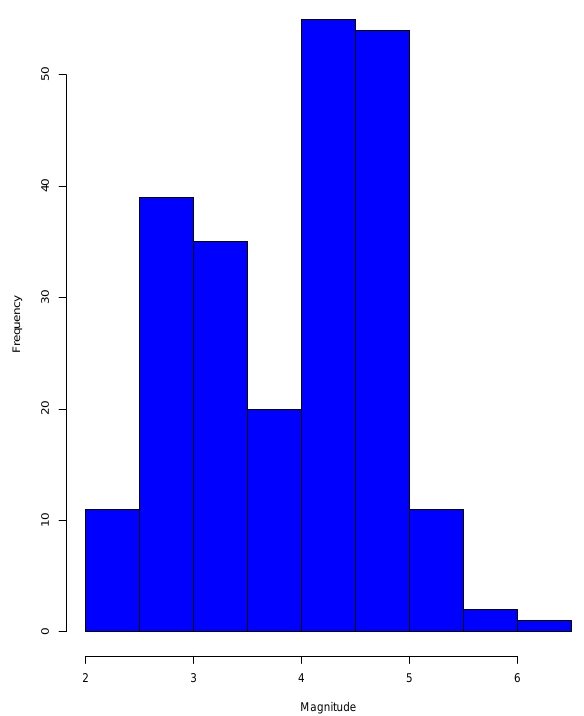
Figure 5. Map of US earthquake data.